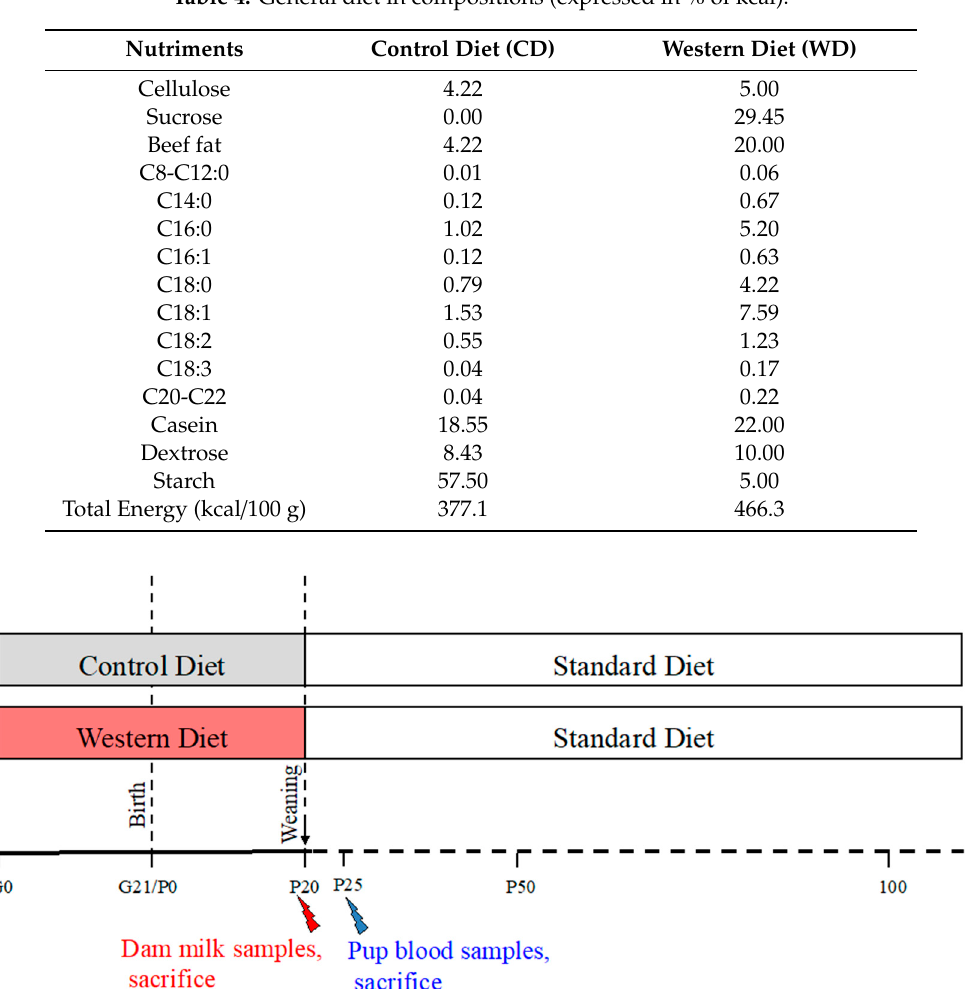
Figure 8. Schematic diagram of the study design. Sixteen female Sprague–Dawley (SPD) rats at gestation day 1 were fed either a control diet for 8 of them or a western diet for the others during gestation and lactation period. Red spark: At day 20, dam milks were sampled and dams were then sacrificed. The offspring were all kept onto standard chow diet until the end of the experiment (P100). Blue spark: At P25 a group of 6 males and 6 females were sacrificed. Table 4. General diet in compositions (expressed in % of kcal).